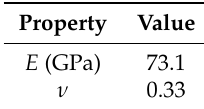
Table 3. Mechanical properties of Aluminum